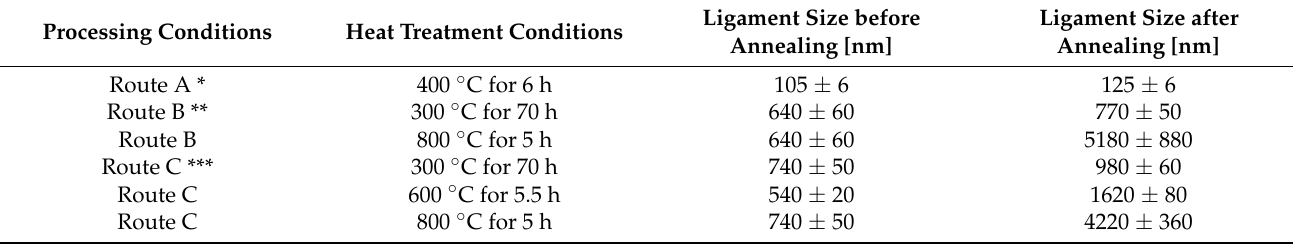
Figure 1. Scanning electron microscopy (SEM) images for Cu foams ( a ) processed by using route B and annealed at ( b ) 300 ◦ C for 70 h and ( c ) 800 ◦ C for 5 h. Table 1. Ligament sizes of Cu foams processed and heat-treated under different conditions before and after thermal annealing.